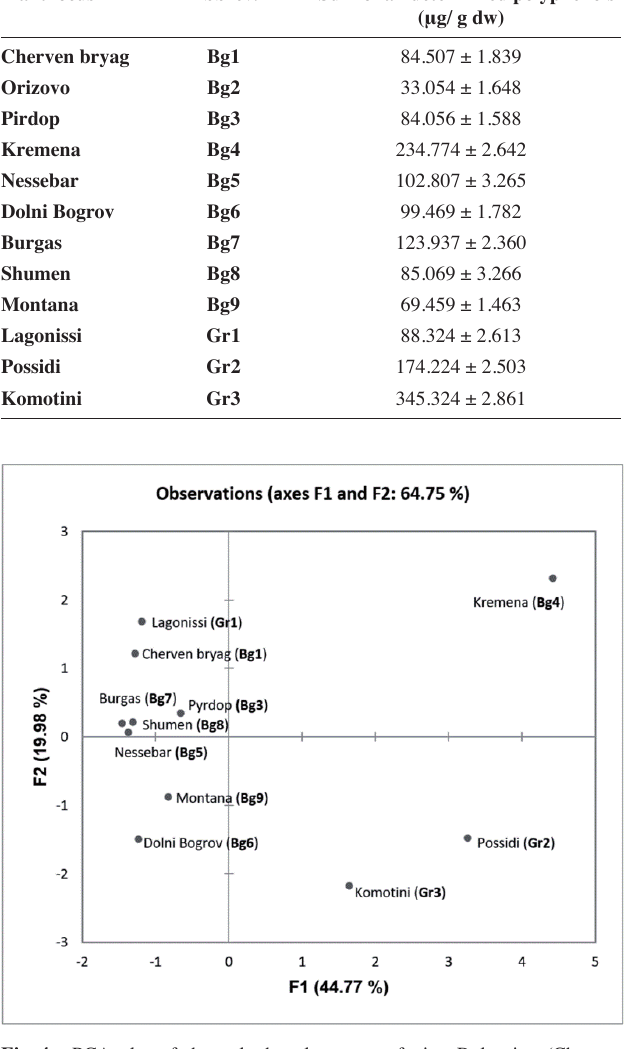
Fig. 4: PCA plot of the polyphenol content of nine Bulgarian (Cherven bryag, Pirdop, Kremena, Nhessebar, Dolni Bogrov, Burgas, Shumen and Montana) and three Greek (Lagonisi, Posidi and Komotini) loci of